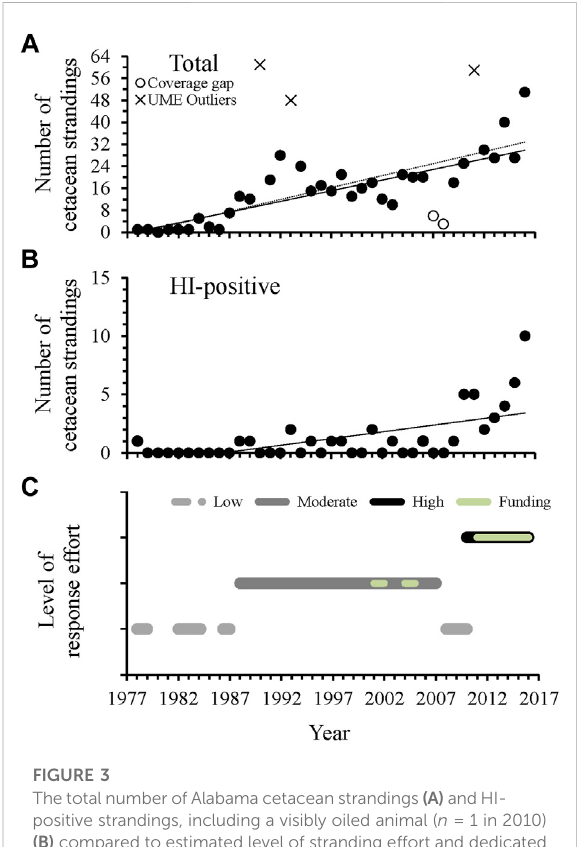
FIGURE 3 ThetotalnumberofAlabama cetacean strandings (A) andHI- positive strandings, including a visibly oiled animal ( n = 1 in 2010) (B) compared to estimated level of stranding effort and dedicated response funding (C) in Alabama waters through time. For total strandings, the solid black line ( y = 0.78 x - 1535.20 R 2 = 0.57, p < 0.001) excludes the documented UMEs that F 1,34 = 44.89, occurred in 1990, 1993 and 2011 (Table 1), which were outliers to theregression.Thedottedblackline( y =0.87 x -1723.70, R 2 =0.71, p < 0.001) additionally excludes data for 2007 and F 1,26 = 35.44, 2008 that coincided with a recent gap in stranding response and wereoutliersto theregressionwhenUMEswereexcluded. ForHI- related strandings, y = 0.12 x - 234.02, R 2 = 0.38; F reg 1,37 = 22.48, p < 0.001, with an exponential increase since 2012 ( y